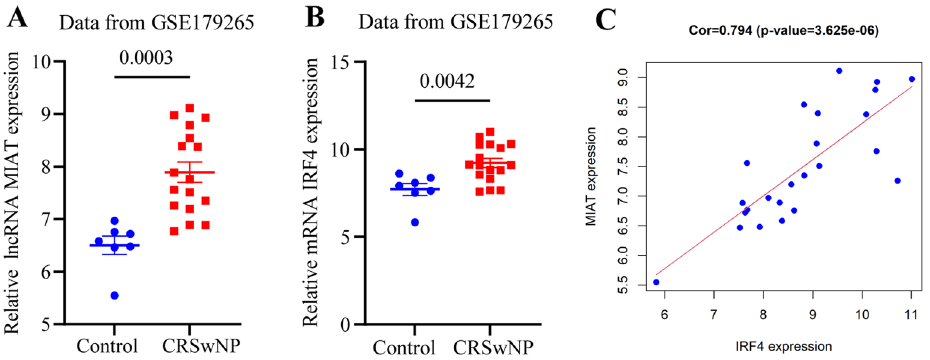
Figure 8. In-silico validation. ( A ) Expression pattern of MIAT in CRSwNP and control subjects. ( B ) Expression pattern of IRF4 in CRSwNP and control subjects. ( C ) Correlation analysis between MIAT and IRF4 in